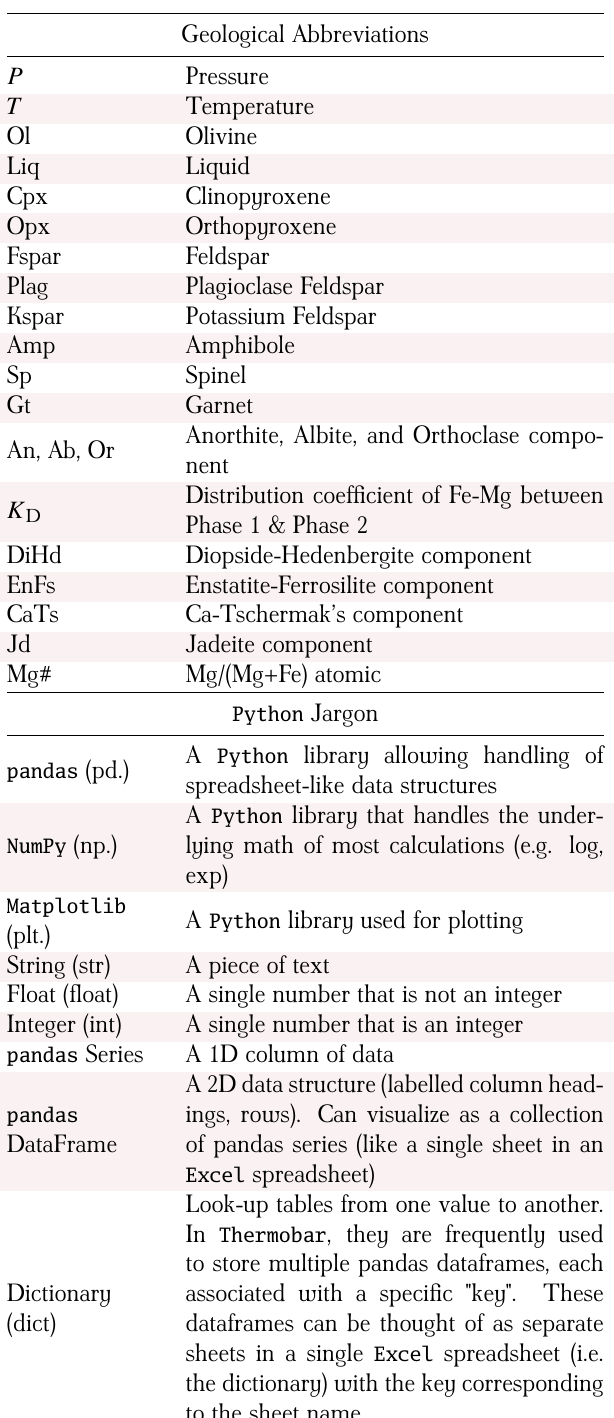
Table 1: List of